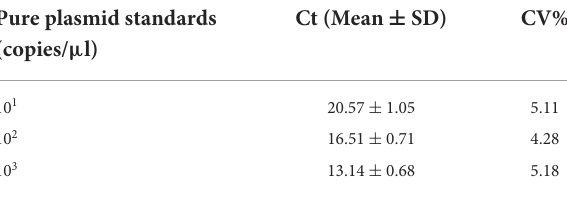
TABLE 2 Real-time RT-RAA repeatability assay of pure plasmid